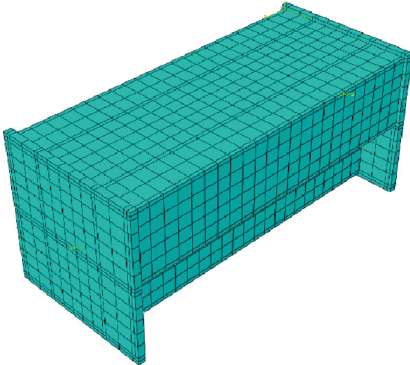
Figure 18: Typical finite element mesh of CFST stub columns.